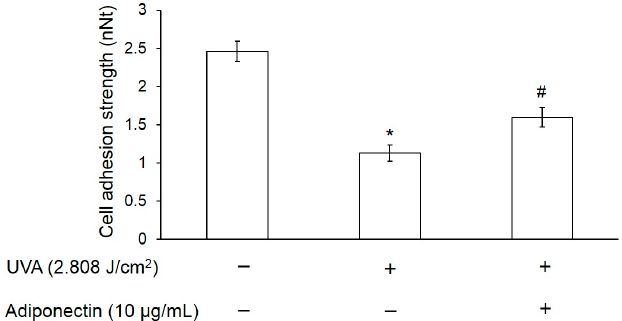
Figure 5. The effect of UVA radiation and adiponectin on cell adhesion strength of human dermal fibroblasts, Hs68. The cell adhesion strength of Hs68 fibroblasts was reduced after 4 h of UVA radiation but partially recovered with 12 h treatment of adiponectin. Data were expressed by the mean of cell adhesion strength compared to control ± standard deviation, n = 30. * p < 0.05 with respect to control; # p < 0.05 with respect to cells treated with UVA radiation. (The symbols of – and + are represented as the absence and presence of UVA or adiponectin.)